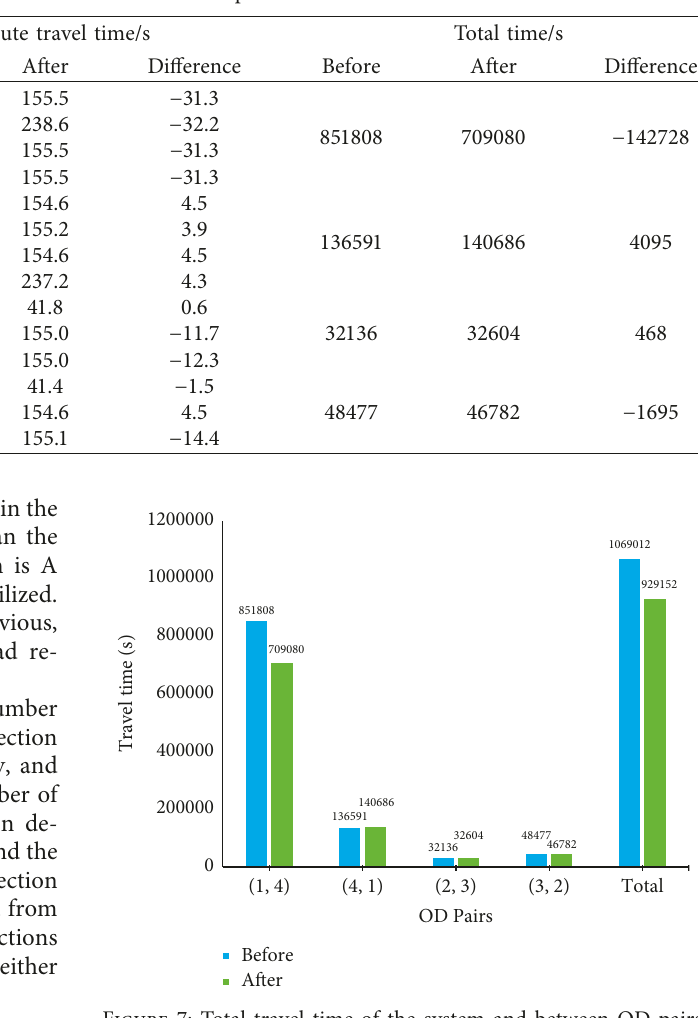
Table 4: Route travel time before and after optimization.